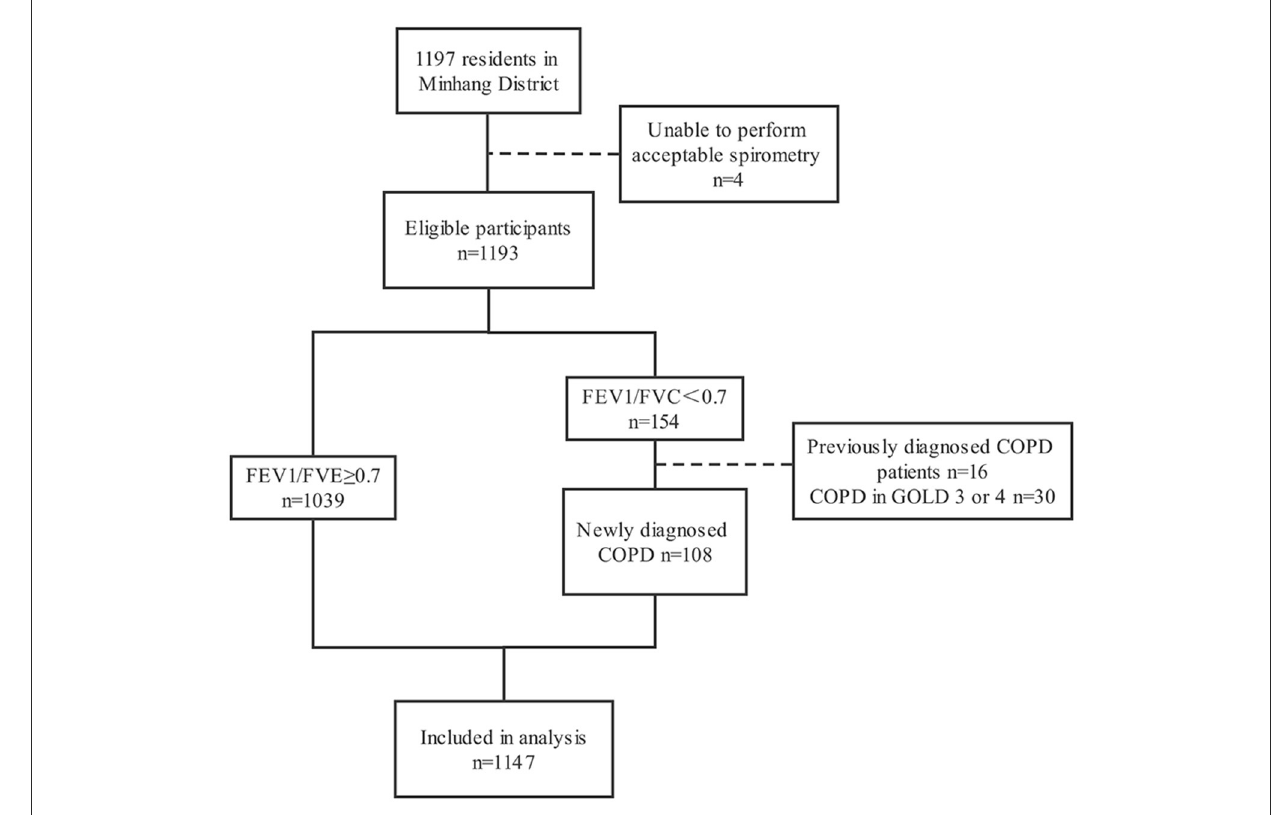
FIGURE1 Study flow